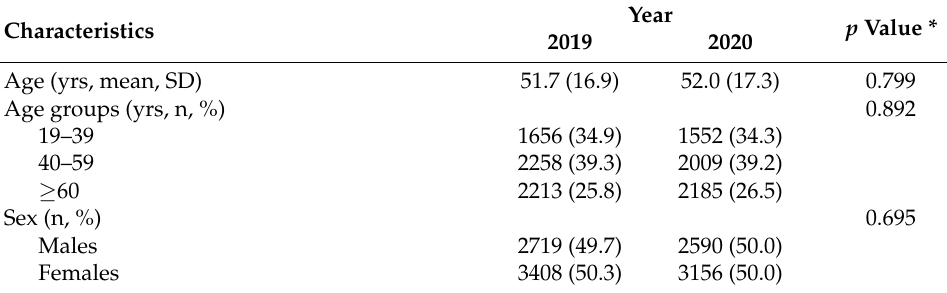
Table 1. General characteristics of